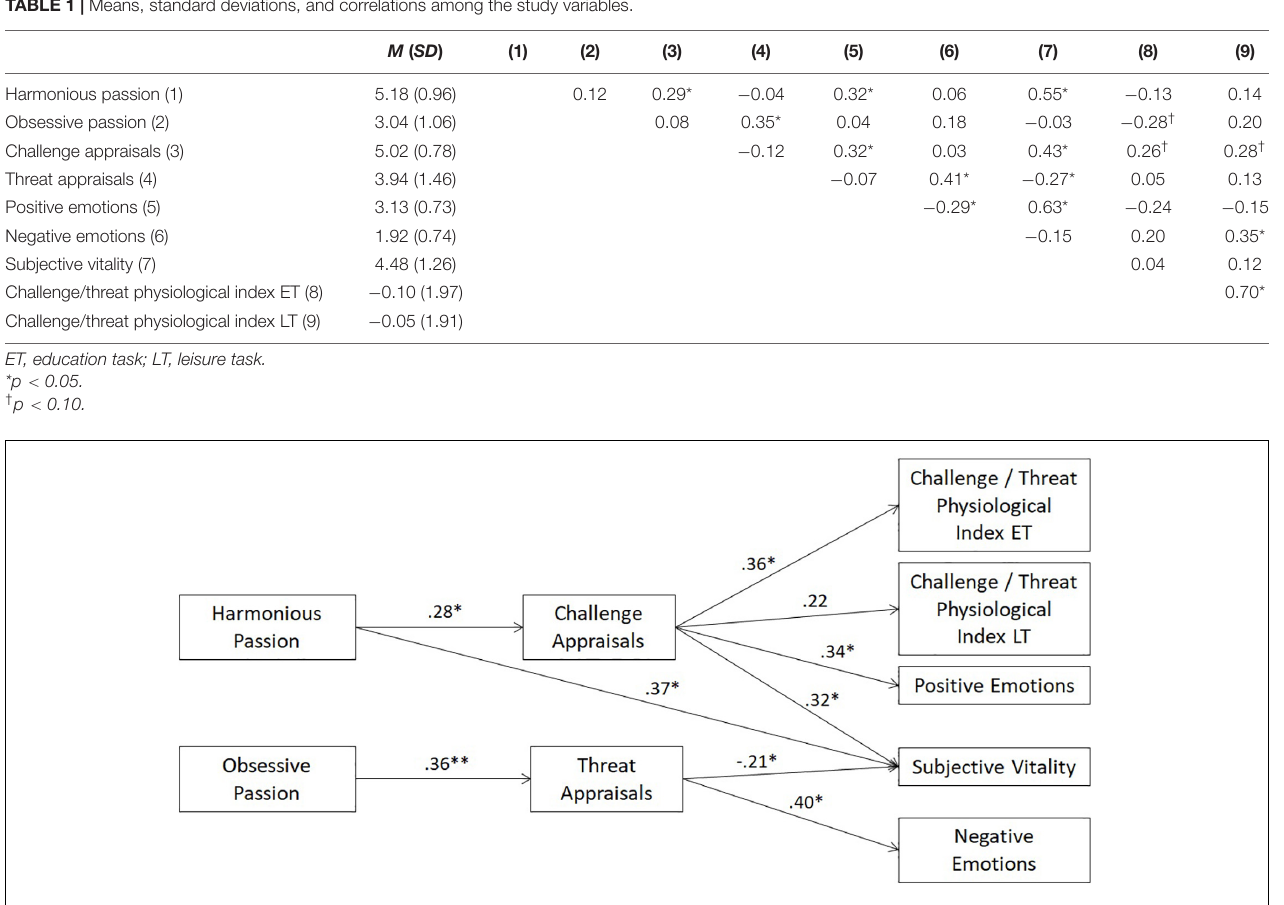
TABLE 1 | Means, standard deviations, and correlations among the study variables.